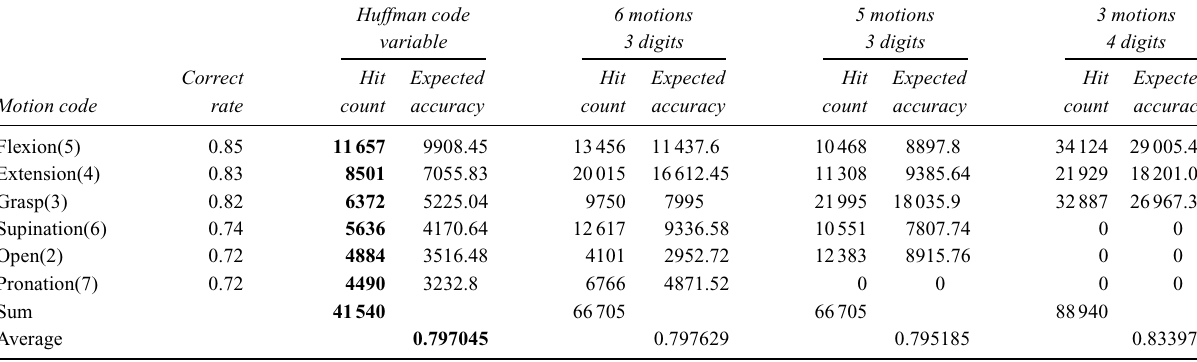
Table 2 Motion number needed and expected average accuracy for the example text in Appendix